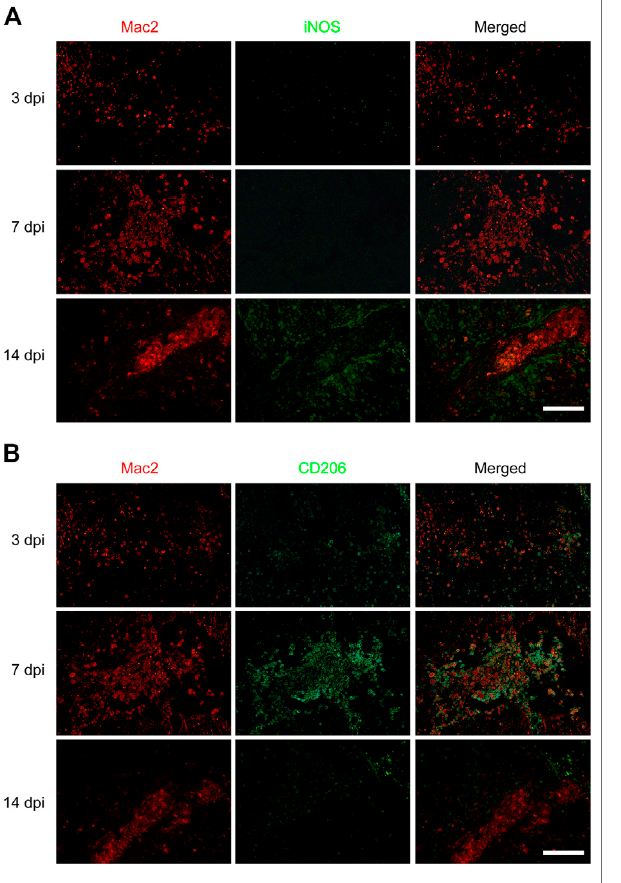
FIGURE 2 | Macrophages polarization after SCI in mice. Immuno fl uorescence staining was used to detect Mac2 + (red) and iNOS + (green) M1 macrophages in (A) or Mac2 + (red) and CD206 + (green) M2 macrophagesin (B) at3,7,and14 dpiintheinjurycore( n (cid:2) 3pergroup). Representative fl uorescence images were presented. Scale bars, 100 μ